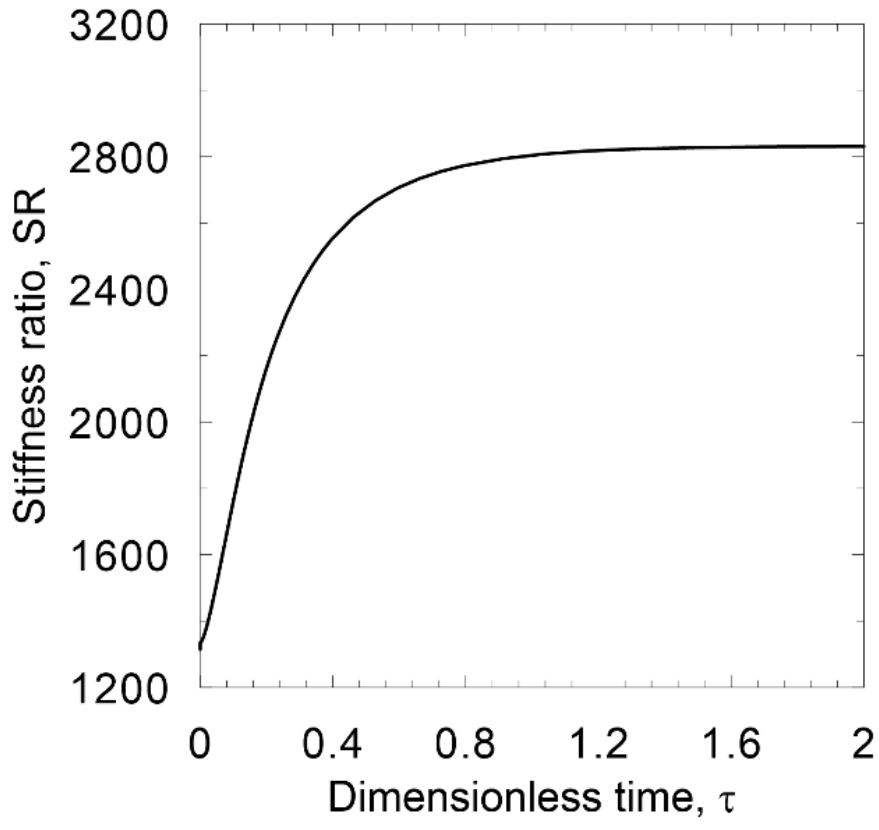
Table 3. Execution times of computer programs solving the exact model and the approximate models.